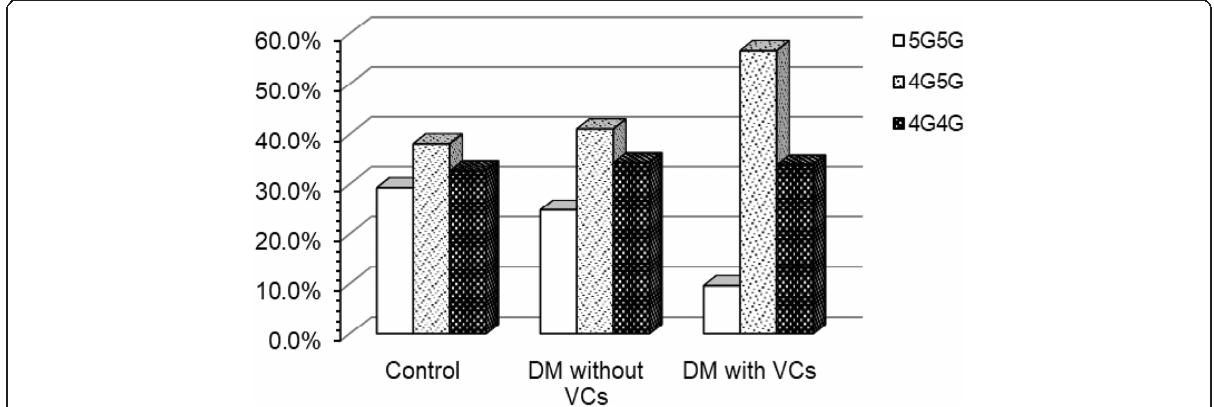
Fig. 1 Genotype distribution of PAI-1 gene polymorphism in the studied